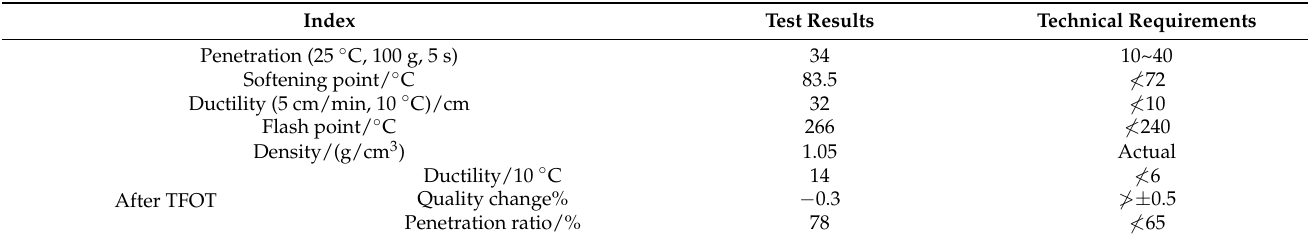
Table 1. Main technical indexes of SBS modified asphalt.